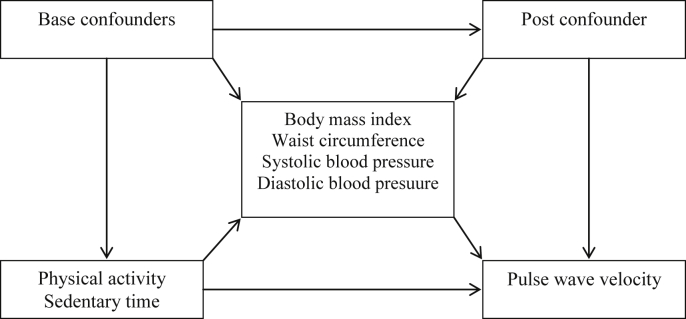
Direct acyclic graph of the effect of physical activity and sedentary time on pulse wave velocity (PWV).